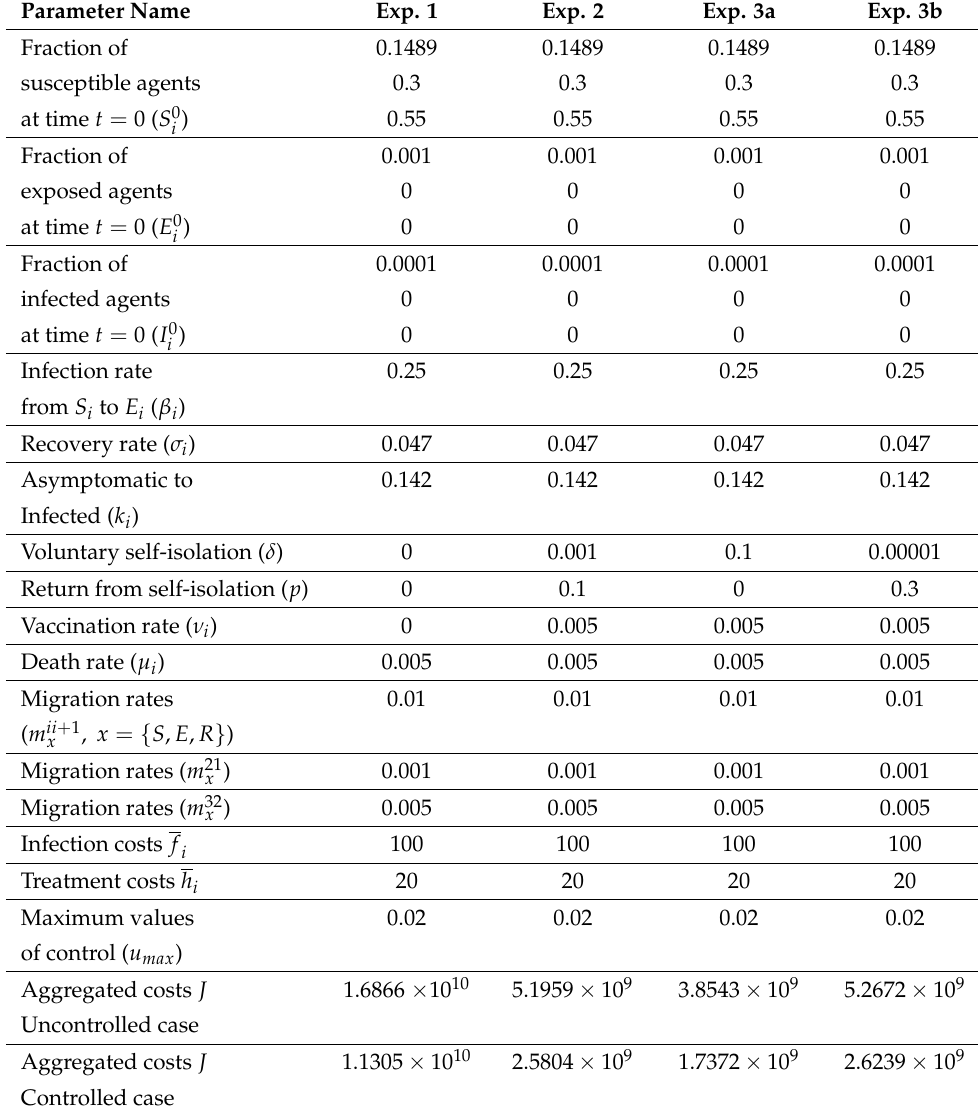
Table 1. Parameters used for simulations in